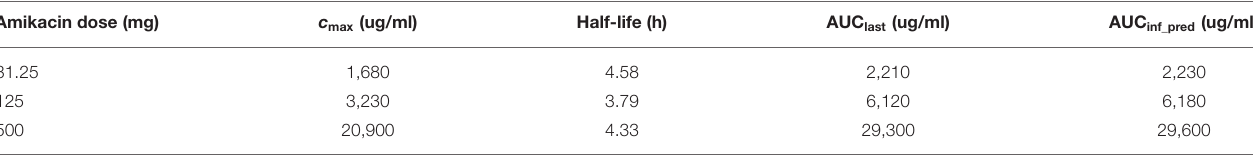
TABLE 2 | Pharmacokinetic parameters evaluated in the synovial fluid following a single intra-articular administration of amikacin at one of three doses to six Quarter Horses. Amikacin dose